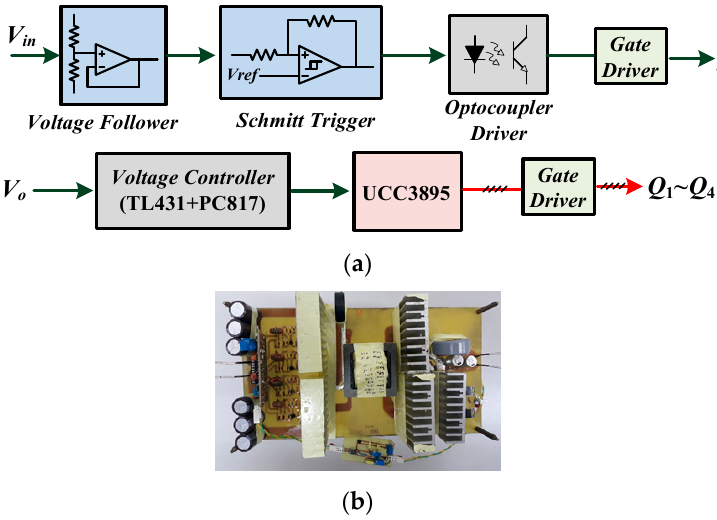
Figure 4. Prototype circuit ( a ) control block of the signals S and Q 1 ~ Q 4 ( b ) picture of the prototype.